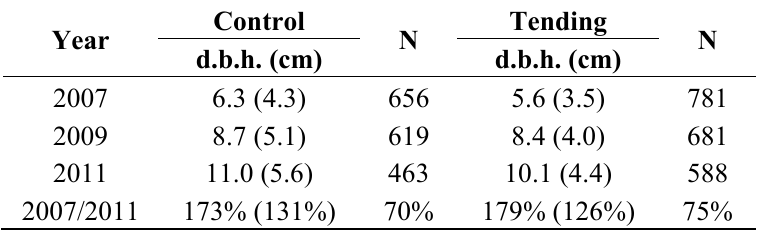
Table A3. Comparison of the number of crop trees (density per ha) and their mean diameter (d.b.h.) on Control and Tending plots according to year of measurement; the standard deviation is given in